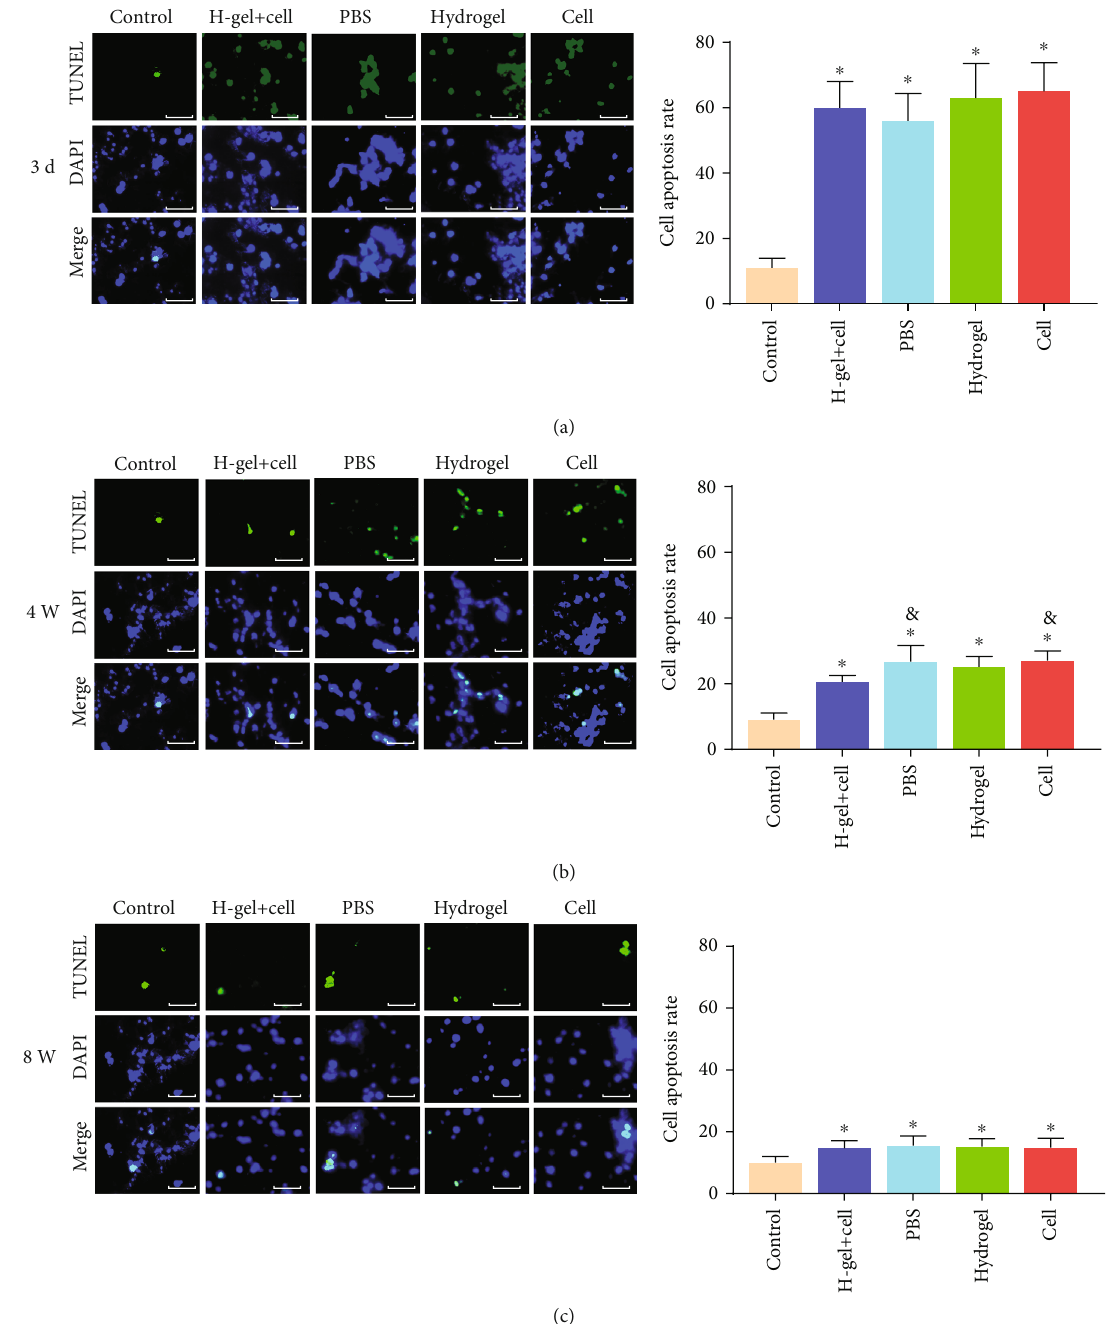
Figure 10: TUNEL staining of di ff erent groups. (a) Representative images and the percentage of TUNEL-positive cells in NP tissues at 3 days after operation. (b) Representative images and the percentage of TUNEL-positive cells in NP tissues at 4 weeks after injection. (c) Representative images and the percentage of TUNEL-positive cells in NP tissues at 8 weeks after injection. The H-gel+cell group is the hydrogel+cell group. Data represent mean ± SD ; the error bars represent the standard deviation of measurements for 6 separate samples ( n = 6 ); ∗ p < 0 : 05 compared with control group; & p < 0 : 05 compared with hydrogel+cell group. Scale bar = 200 μ m